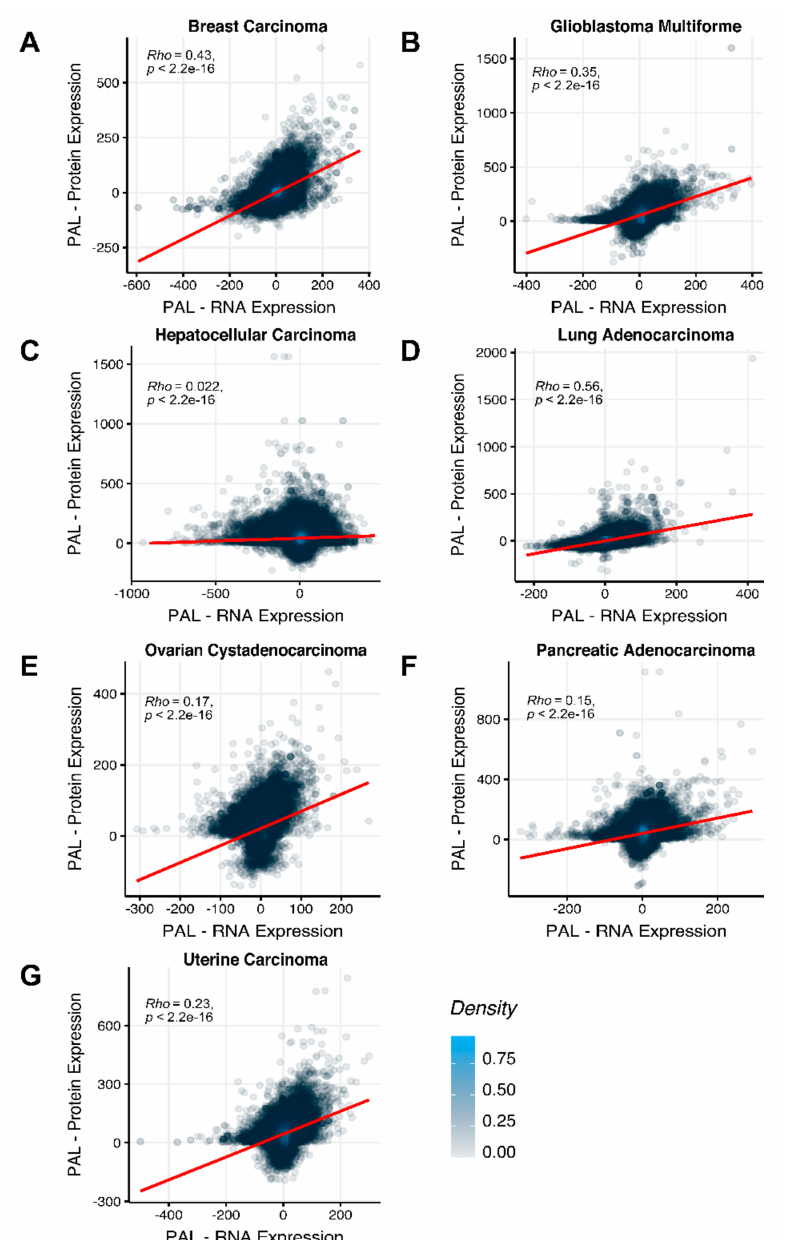
Figure 3. PAL-to-PAL Spearman correlation between RNA and protein expression levels for an average biosample estimated across ( A ) Breast Invasive Carcinoma, ( B ) Glioblastoma Multiforme, ( C ) Hepatocellular Carcinoma, ( D ) Lung Adenocarcinoma, ( E ) Ovarian Serous Cystadenocarcinoma, ( F ) Pancreatic Ductal Adenocarcinoma and ( G ) Uterine Corpus Endometrial Carcinoma. Each dot represents a unique gene-sample